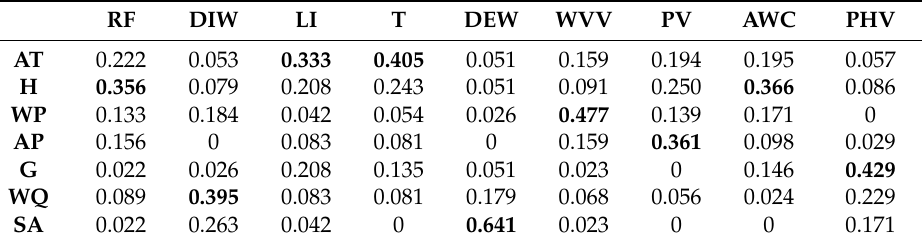
Table 5. Similarity results based on instance strategy.